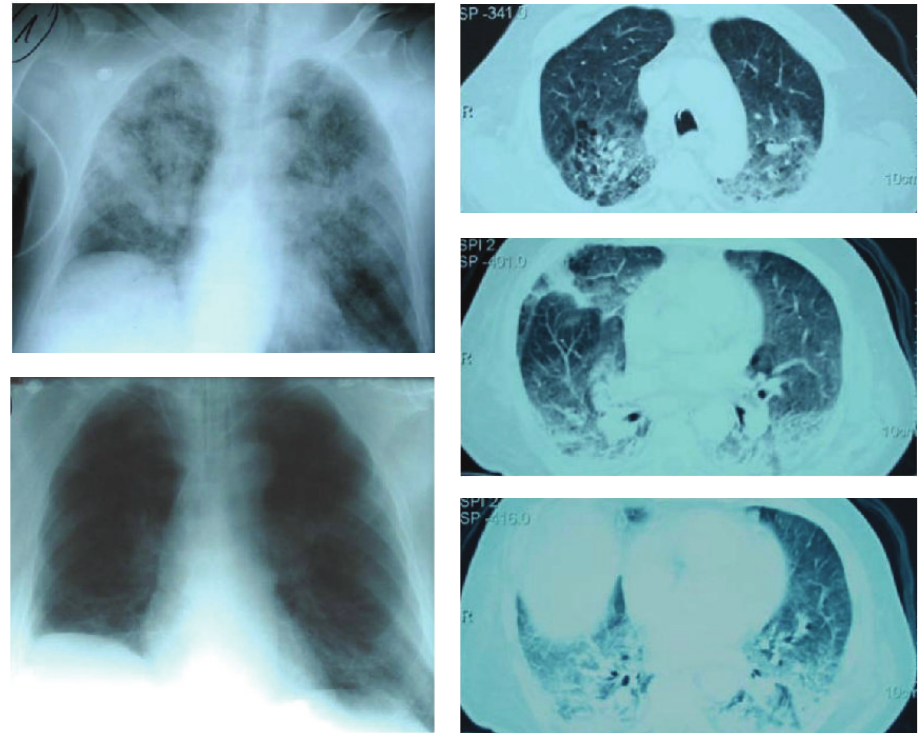
Figure 1: Chest X-rays and CT scan. Patchy bilateral infiltrates can be seen in the first chest X-ray made immediately postoperatively (top left). After three days of noninvasive ventilation and two days of invasive ventilation, the CT scan of the lungs was performed at a PEEP of 15cm H 2 O (right) showing bilateral dorsal infiltrates reaching from cranial (top right) to caudal lung regions (down right). The chest X-ray made after CENPV during the following day shows impressive regression of the infiltrates and pleural effusions (bottom left), corresponding to improved